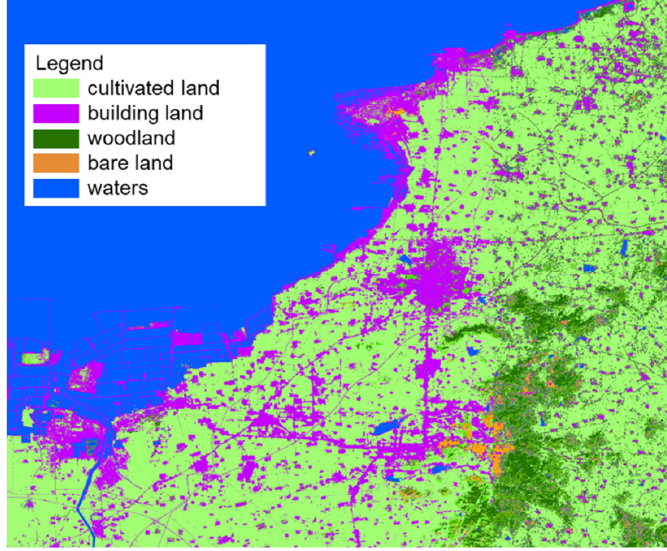
Figure 2. Land use pattern of the study area.